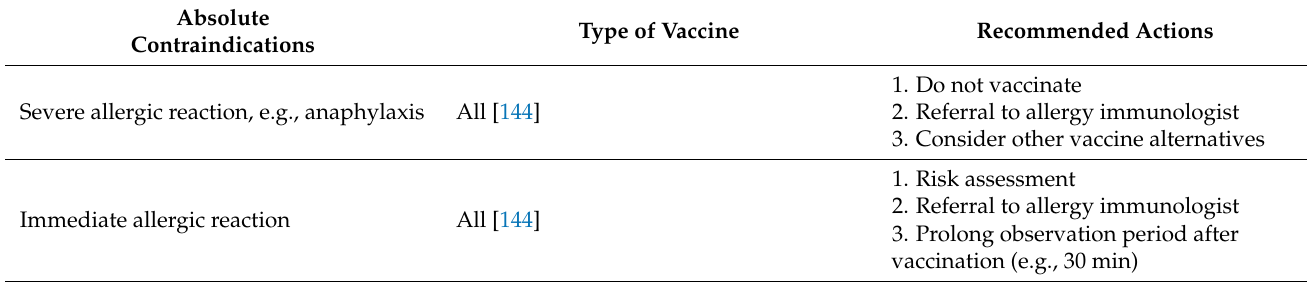
Table 1. Absolute contraindications of